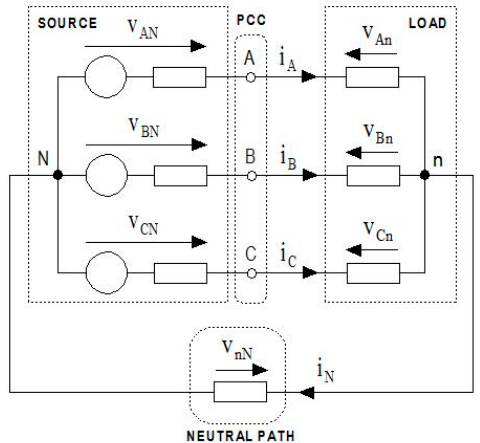
Figure 1. Three-phase, four-wire, unbalanced, non-sinusoidal power system. (The head of the arrow voltages indicates the point of greatest potential).